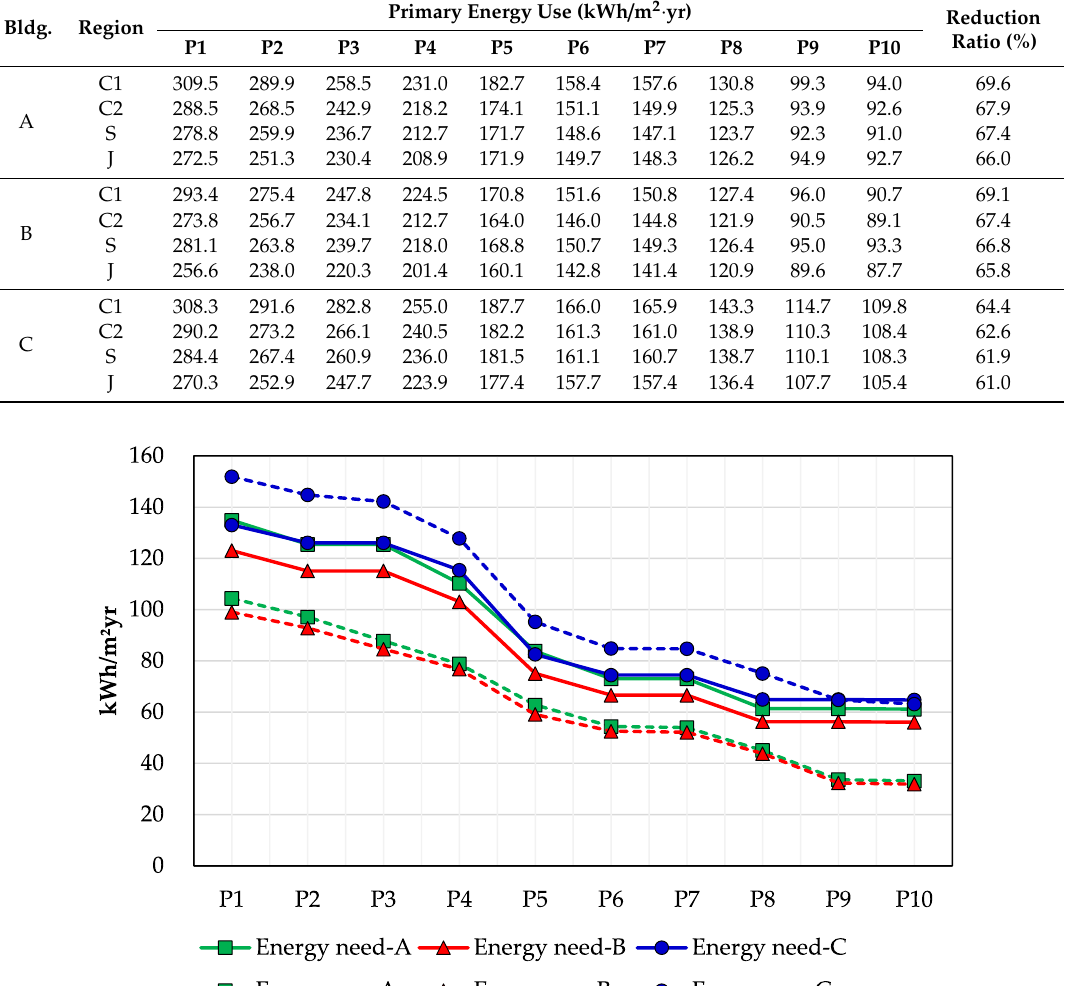
Table 12. The primary energy use of the reference buildings according to the reinforcement of the BECC. Bldg. Region